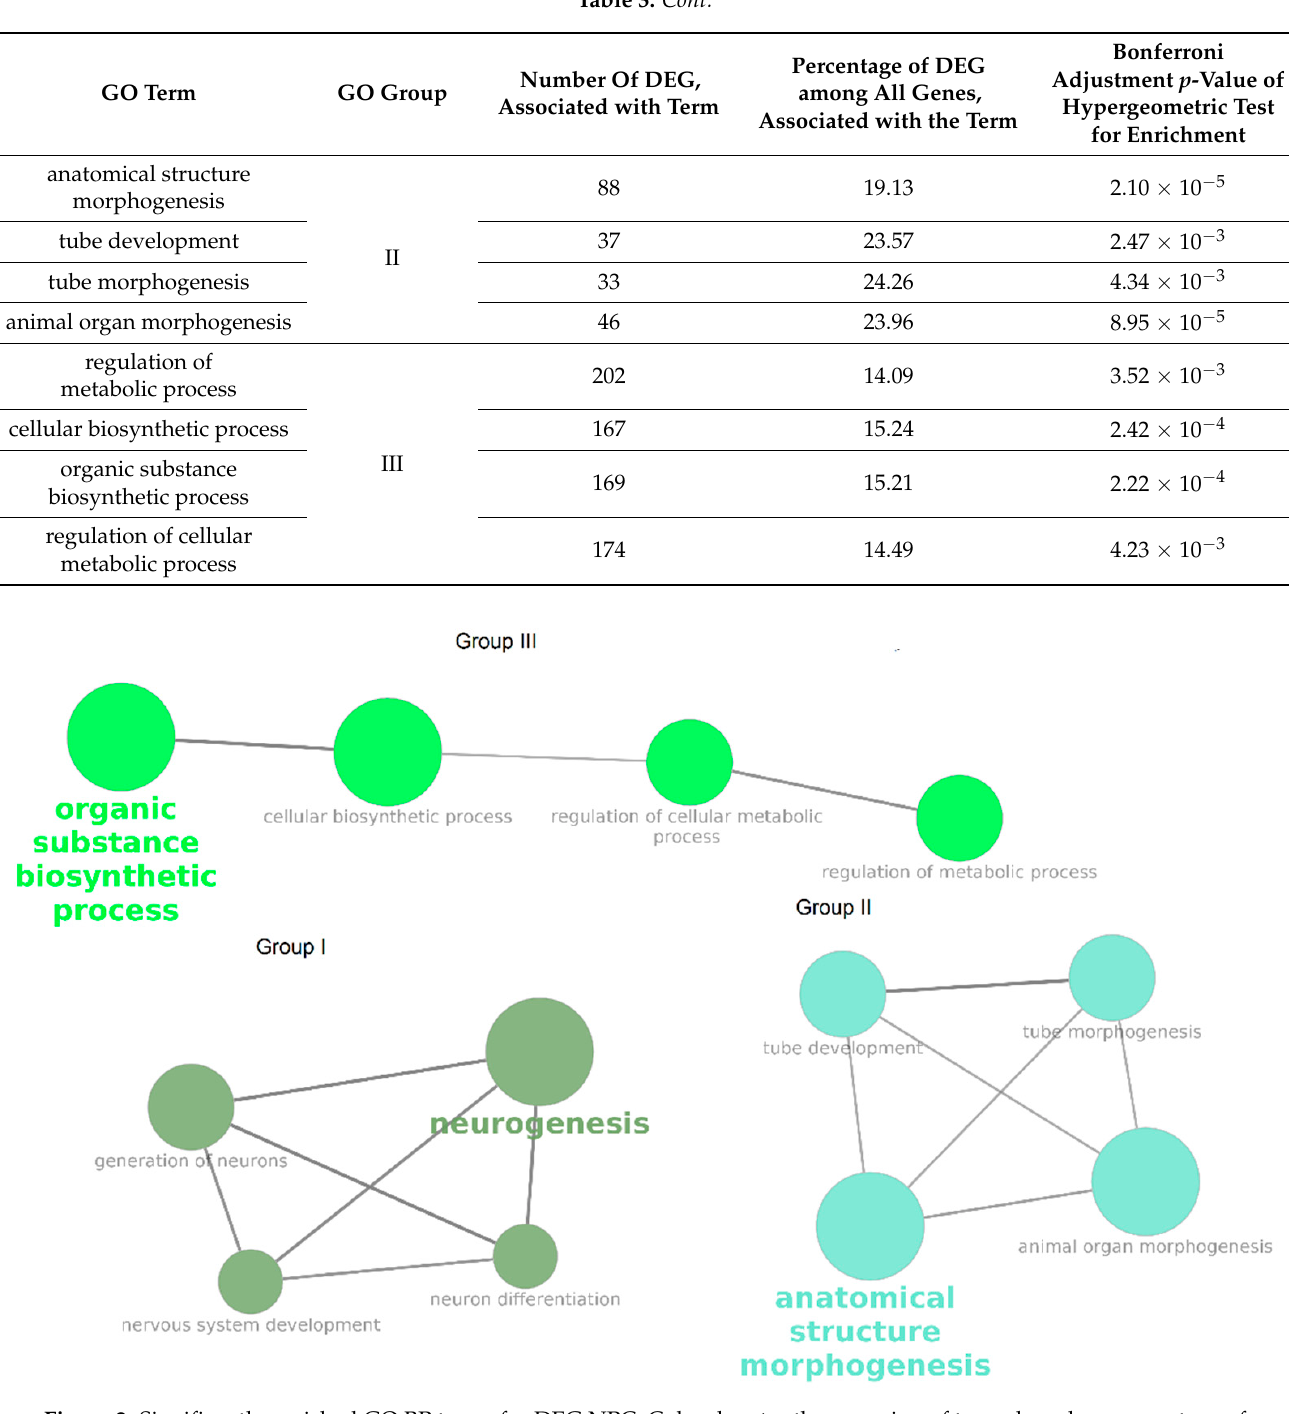
Figure 2. Significantly enriched GO BP terms for DEG NPC. Color denotes the grouping of terms based on percentage of common genes.